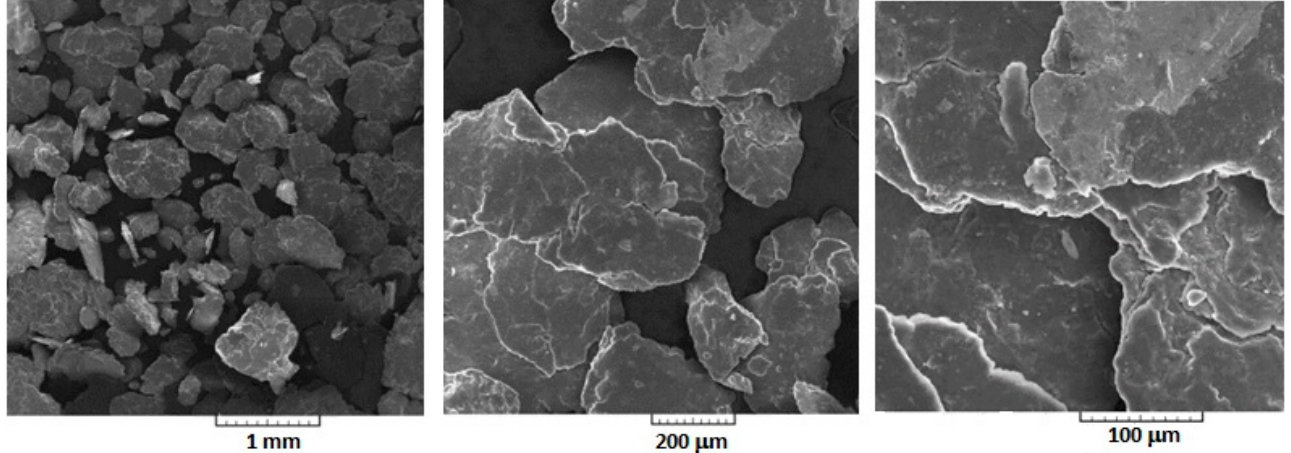
Figure 5. The Mg ‐ 10Zn ‐ 0.8Ca ‐ 0.5Zr (wt.%) alloy ‐ powder processed by mechanical alloying with 200 rpm/20 h/10:1.